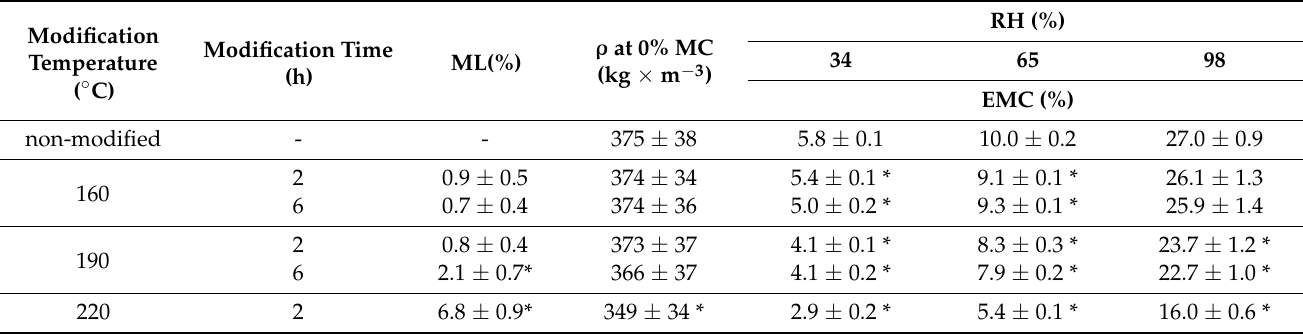
Table 4. Mass loss (ML), density ( ρ ), equilibrium moisture content (EMC) at different relative humidity (RH) determined for black poplar, non-modified and thermally modified in nitrogen atmosphere; ±